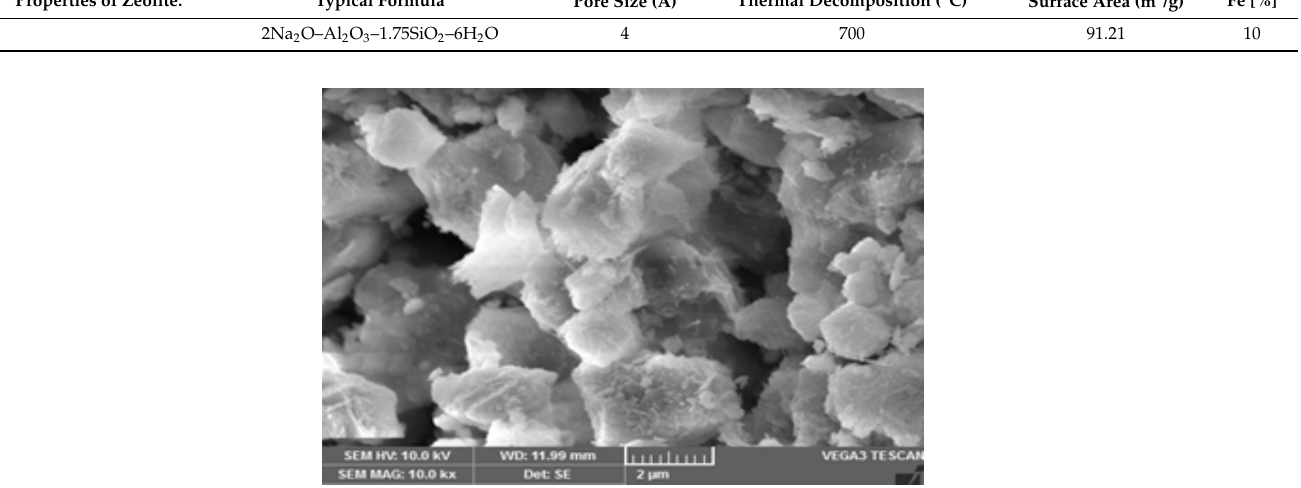
Figure 1. Scanning electron microscope (SEM) image of Fe-Zeolite A.